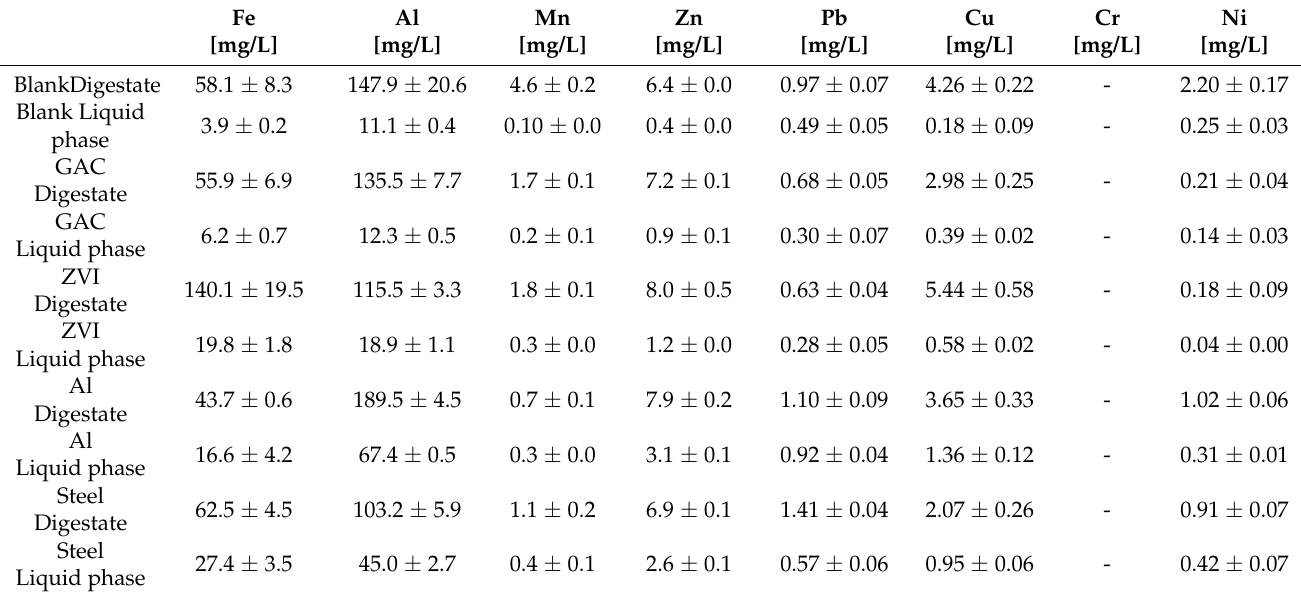
Table 2. Characterization of the final